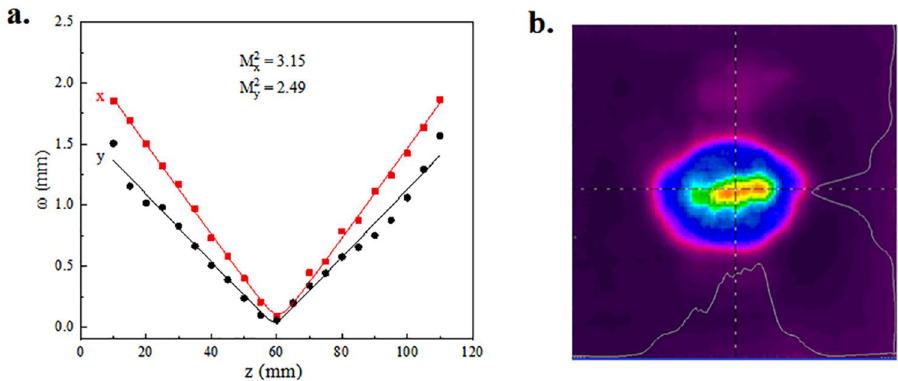
Figure 6. Beam quality of IC-OPO. ( a ) Hyperbola fitting of M 2 at 3.9 μm. The dots mean measured value while the line is fitting curve. x represents horizontal value while y shows vertical value. ( b ) Intensity distribution of idler beam at 3.9 μm. (Origin 2018, https ://www.origi nlab.com/, pyrocam III control console, pyrocam III control driver, https ://www.ophir opt.com/, Adobe Photoshop CC 2018, https ://www.adobe .com/cn/produ cts/ photo shop.html/).